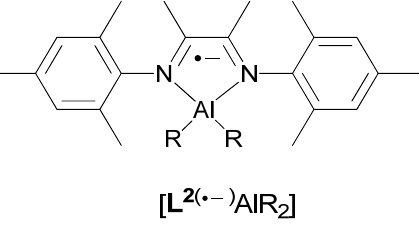
Figure 4. The structure of L 2 (• − ) AlR 2 , formed in the systems L 2 Ni II Br 2 /AlMe 3 or L 2 Ni II Br 2 /MMAO (R = Me or i Bu).